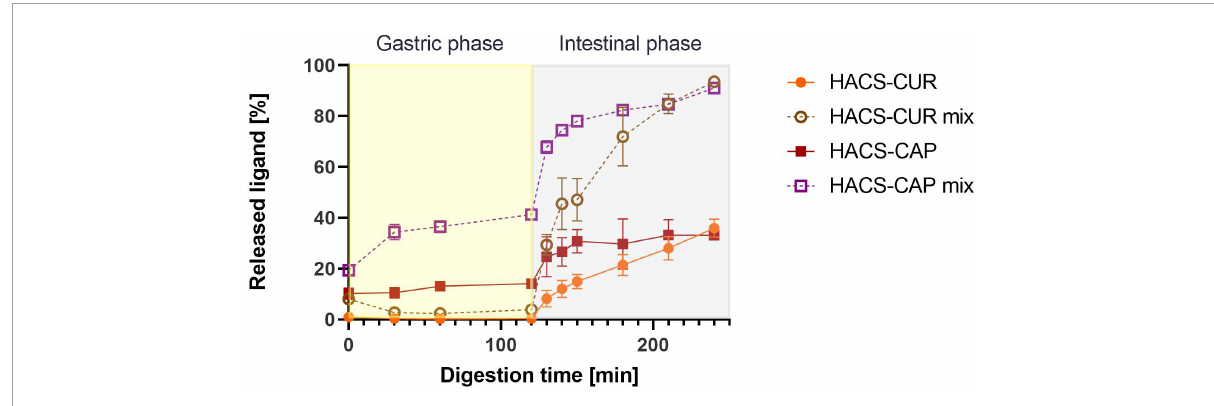
FIGURE7 Release profiles of CUR and CAP in an adult in vitro digestion model.